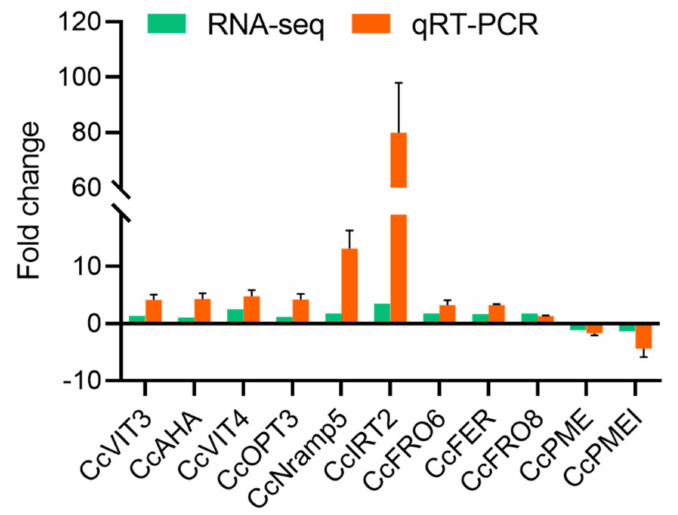
Figure 7. RT − qPCR verification of transcriptome data for camphor tree roots with and without